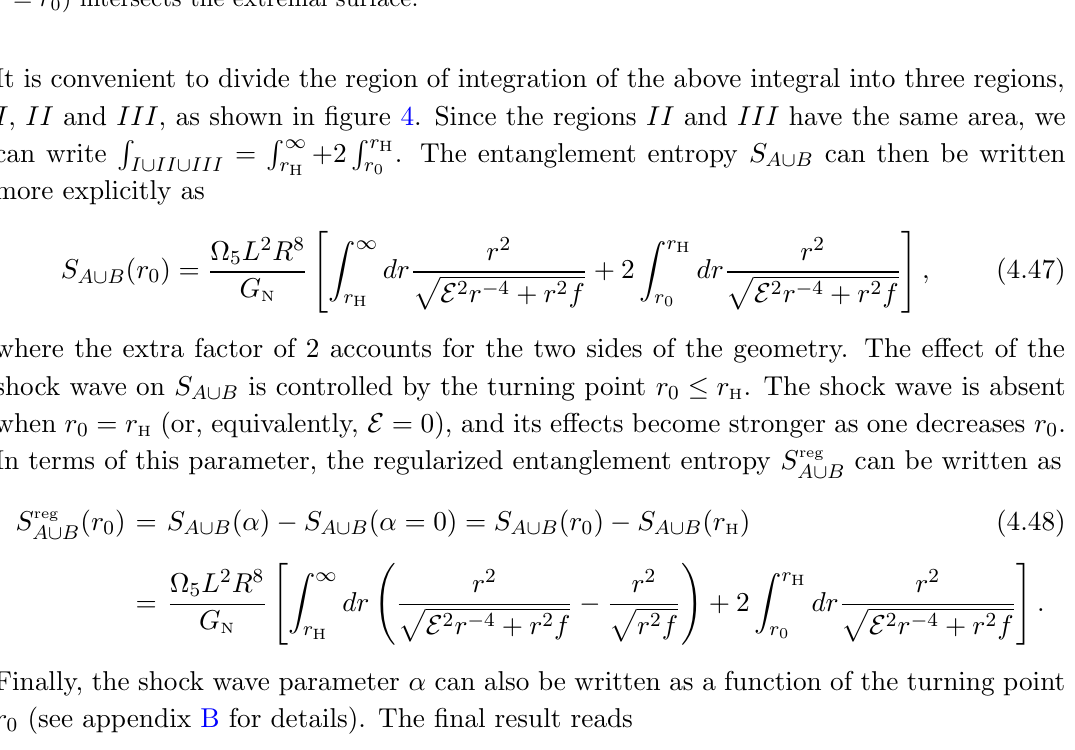
Figure 4 . Extremal surface (horizontal, red) in the shock wave geometry. We divide the left half of the surface into three parts, I , II and III . The segments II and III have the same area and they are separated by the point r 0 at which the constant- r surface (blue, dashed curve, de(cid:12)ned by r = r 0 ) intersects the extremal